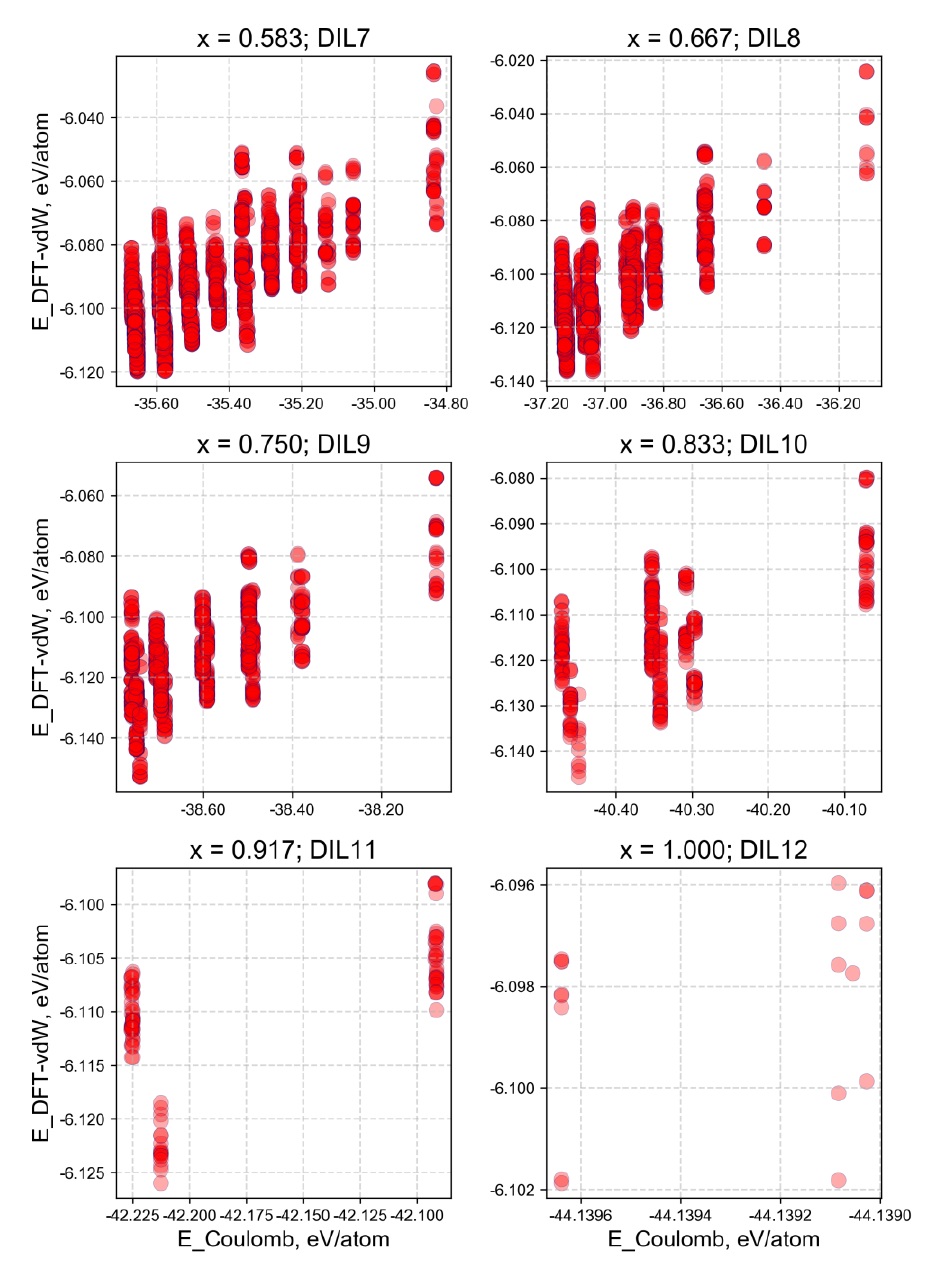
Fig. 2. Comparison of the DFT-vdW ( E_DFT-vdW ) and Coulomb ( E_Coulomb ) energies for the NCA CCS subset corresponding to medium-high and high DILs: Li 1-x Ni 0.8 Co 0.15 Al 0.05 O 2 , where 0.5 < x ≤1